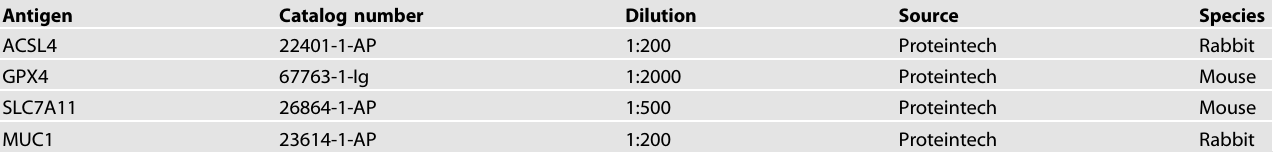
Table 2. Details of antigens used in WB assays.